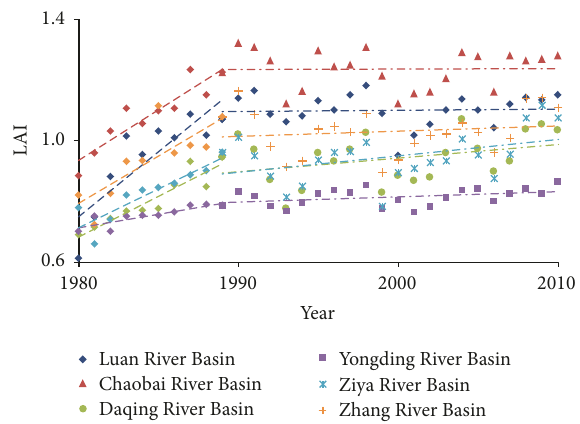
Figure 3: Changes in the annual leaf area index (LAI) in the six subbasins. The figure shows the results of a linear fitting to the LAI values before (the dashed line) and after (the dash dotted line)